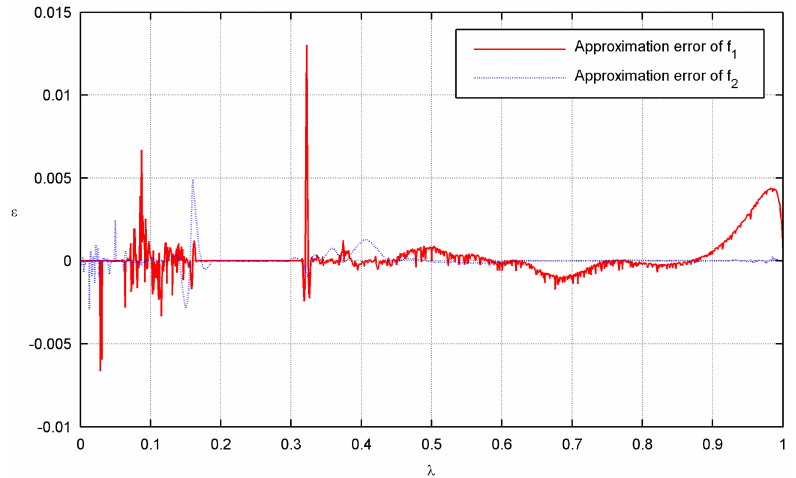
Fig 11. Approximation error of the optimal